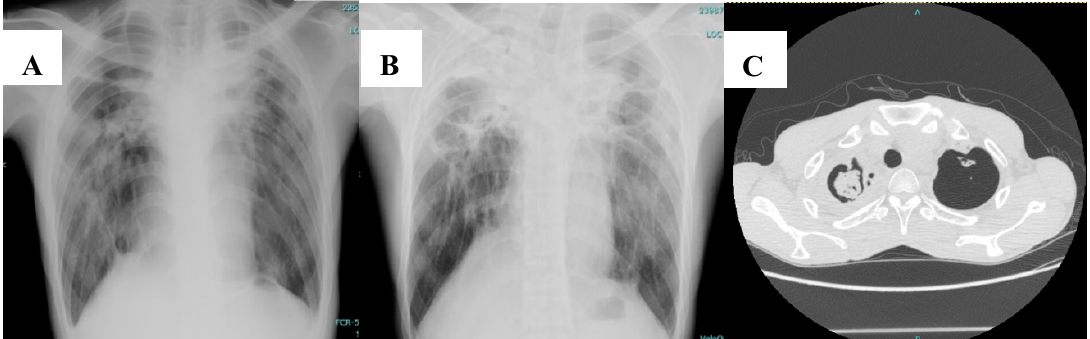
Figure 1 . Chest imaging of a 37 - year - old man diagnosed with chronic pulmonary aspergillosis Figure 1. Chest imaging of a 37-year-old man diagnosed with chronic pulmonary aspergillosis following following pulmonary Mycobacterium avium infection . ( A ) Chest radiograph showed cavitary lesion at pulmonary Mycobacterium avium infection. ( A ) Chest radiograph showed cavitary lesion at right upper right upper lobe ( pulmonary Mycobacterium avium infection ). ( B ) Chest radiograph 1 year later lobe (pulmonary Mycobacterium avium infection). ( B ) Chest radiograph 1 year later showed thickening showed thickening of pre - existing cavities, with pericavitary infiltration ( chronic pulmonary of pre-existing cavities, with pericavitary infiltration (chronic pulmonary aspergillosis). ( C ) Computed aspergillosis ). ( C ) Computed tomography of the chest showed a fungal ball in the pre - existing cavity . tomography of the chest showed a fungal ball in the pre-existing